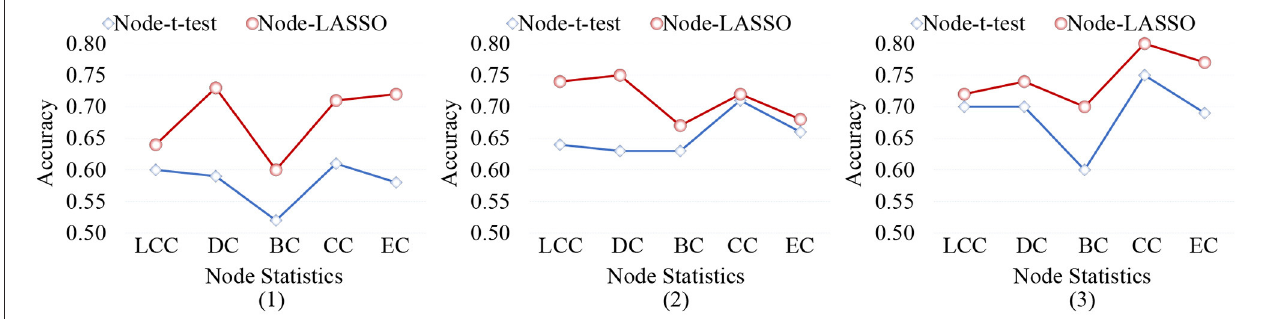
FIGURE 9 | Classification accuracy achieved by the node-level methods using different node statistics in three tasks of (1) lMCI vs. eMCI, (2) eMCI vs. NC, and (3) AD vs. NC classification. LCC, local clustering coefficient; DC, degree centrality; BC, betweenness centrality; CC, closeness centrality; EC, eigenvector